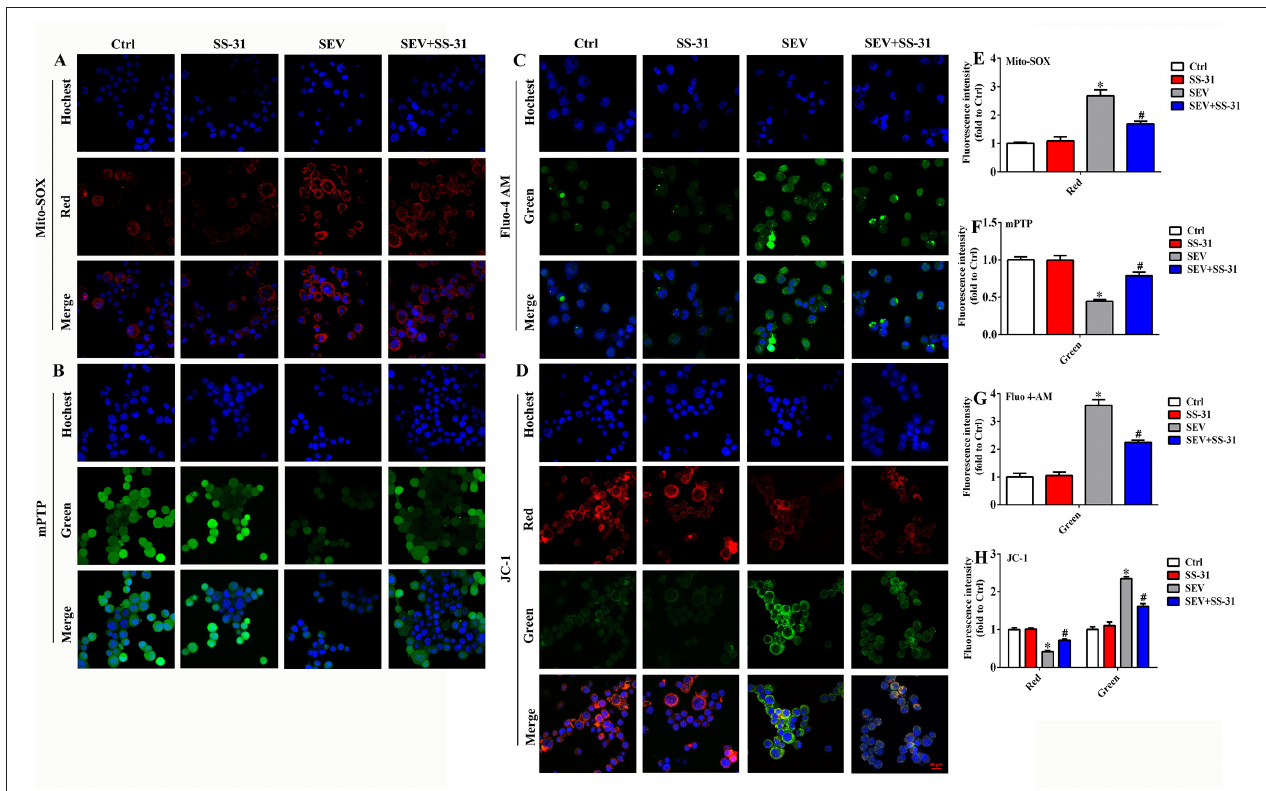
FIGURE 4 | Sevoflurane administration induced mitochondrial dysfunction. (A,E) MitoSOX staining for detecting the level of mitochondrial ROS [one-way ANOVA, Tukey’s multiple comparisons test, Treatment: F (1.969,3.938) = 122.4, mean difference (95% CI): − 1.680 ( − 2.466 to − 0.8936) (Ctrl vs. SEV) and 0.9879 (0.3192 to 1.657) (SEV vs. SEV + SS-31), p < 0.001]; (B,F) mitochondrial permeability transition pore assay for assessing membrane permeability [one-way ANOVA, Tukey’s multiple comparisons test, Treatment: F (1.612,3.224) = 26.41, 0.5541 (0.3417 to 0.7666) (Ctrl vs. SEV) and − 0.3411 ( − 0.7706 to 0.08832) (SEV vs. SEV + SS-31), p < 0.05]; (C,G) Fluo calcium indicators for investigating cytoplasm calcium levels [one-way ANOVA, Tukey’s multiple comparisons test, Treatment: F (1.164,2.329) = 69.84, − 2.578 ( − 3.406 to − 1.749) (Ctrl vs. SEV) and 1.336 (0.06602 to 2.606) (SEV vs. SEV + SS-31), p < 0.01]; (D,H) JC-1 probe for determining mitochondrial